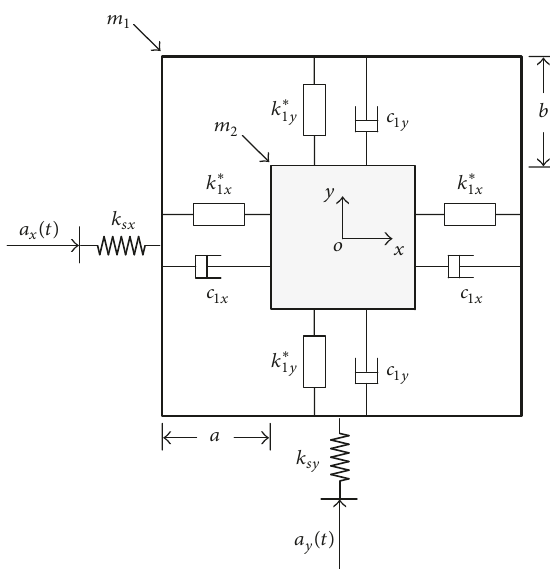
to connect the frame structure and the power modules at a precompressed way, and this connection is just surface- contact, which means the viscoelastic connecting parts are not fixed or limited in determined positions.